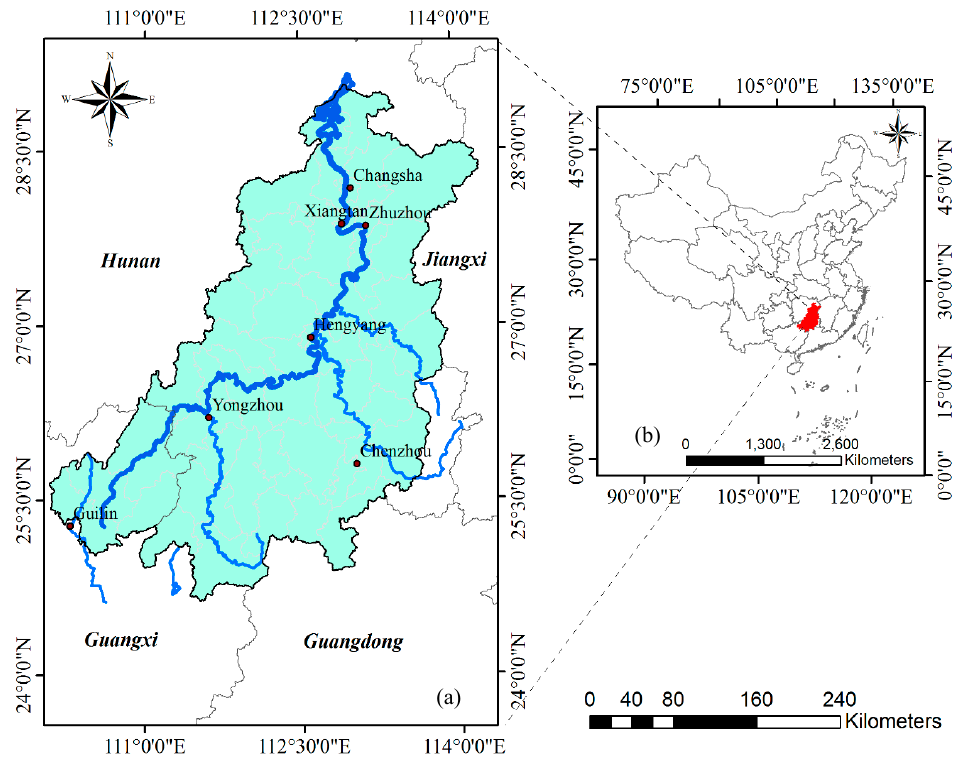
Figure 1. The study area: ( a ) the Xiangjiang River Basin in cyan with the river in blue; and ( b ) the basin location in China marked in red.